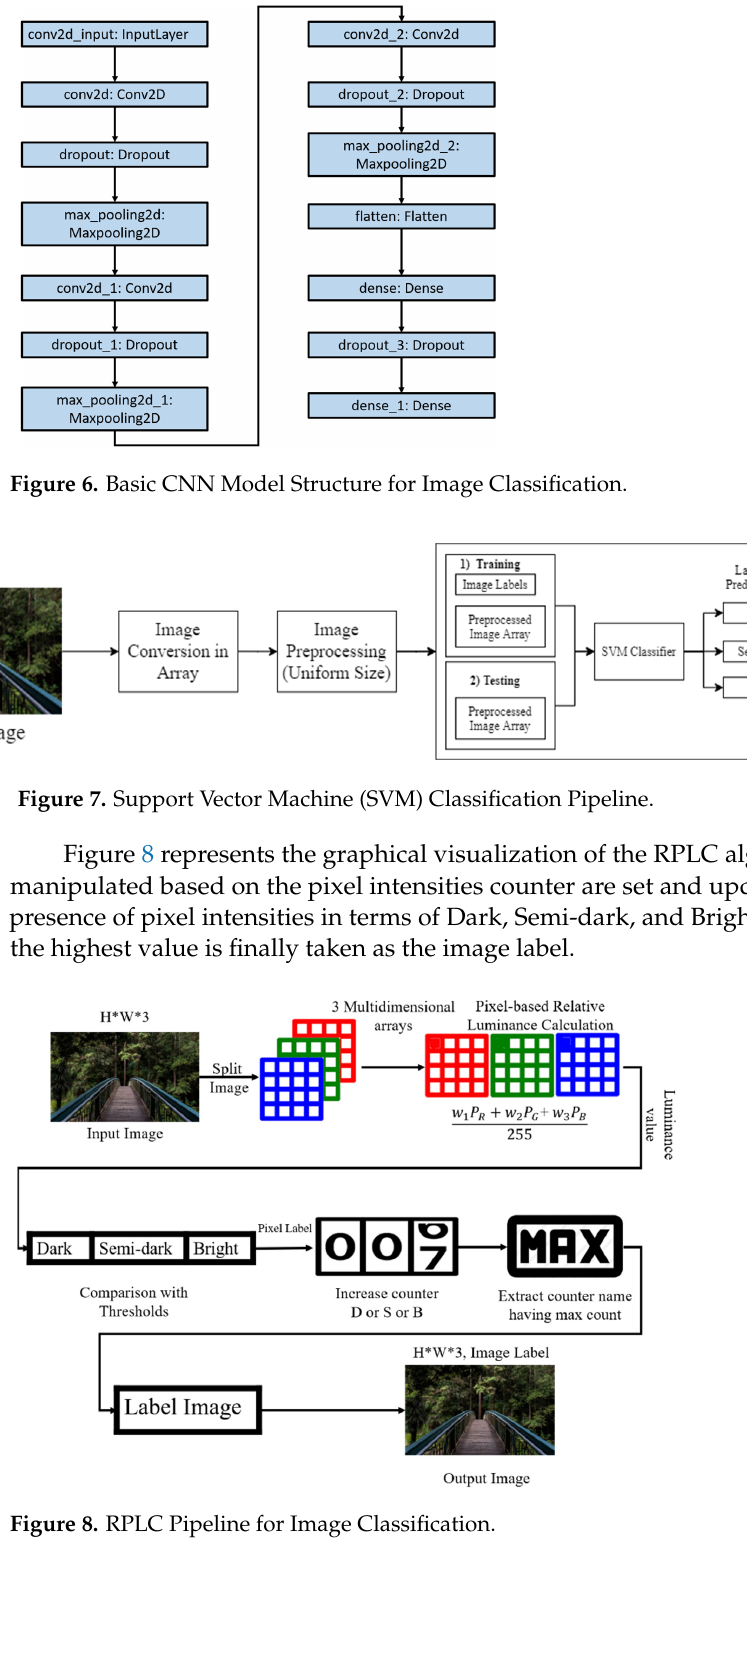
Figure 8. RPLC Pipeline for Image Classification.